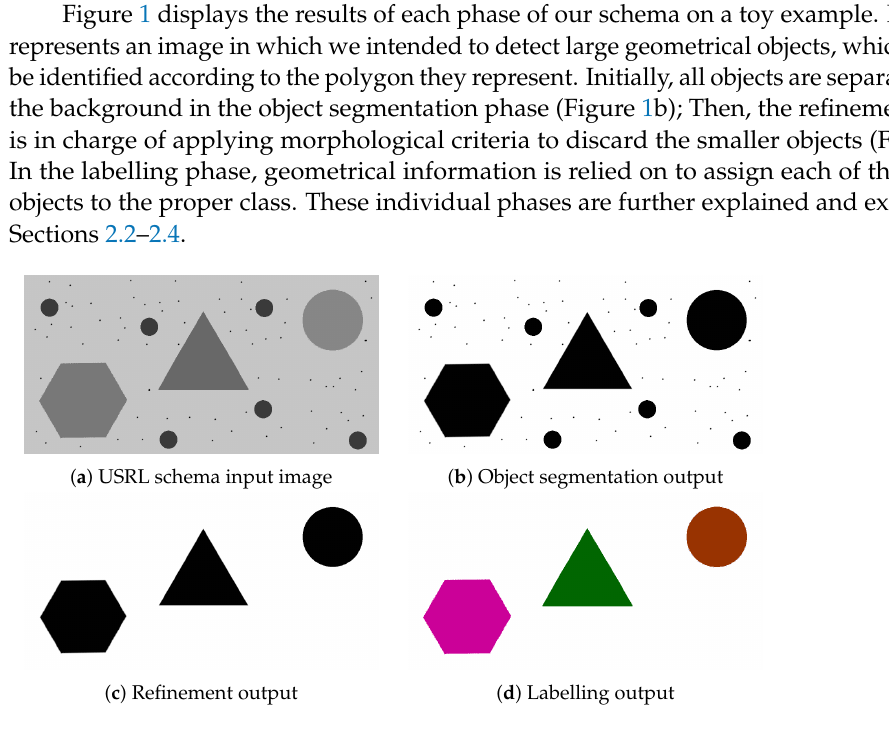
Figure 1. Visual representation of the USRL schema workflow: ( a ) the original USRL schema input image; ( b ) the output resulting from the object segmentation phase; ( c ) the refinement output of ( b ), eliminating unwanted objects and noise; ( d ) the final labelled image, where each class comes with an associated